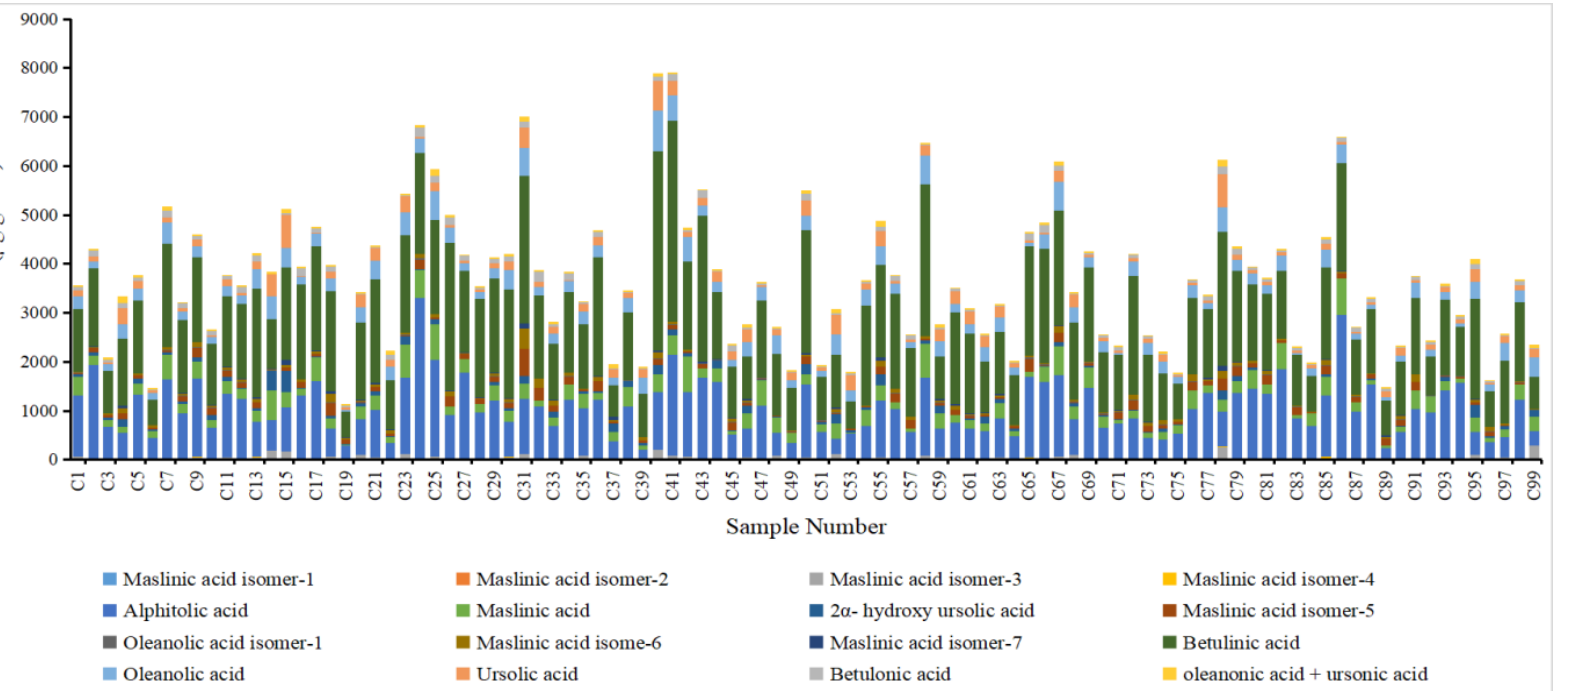
Figure 3. Contents (µg/g dry weight (DW)) of triterpenic acids in different jujube samples.